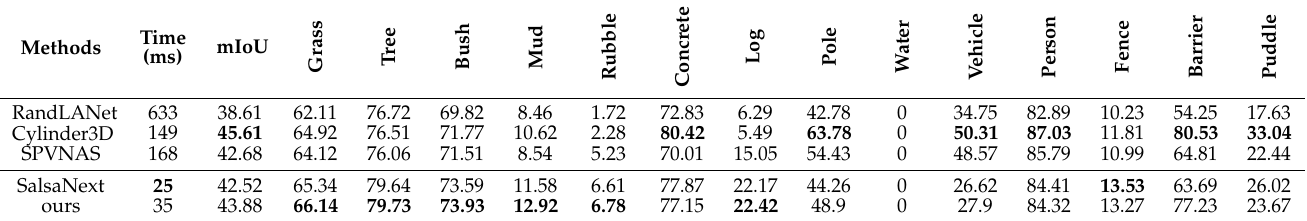
Table 2. Comparisons with state-of-the-art methods on the RELLIS-3D